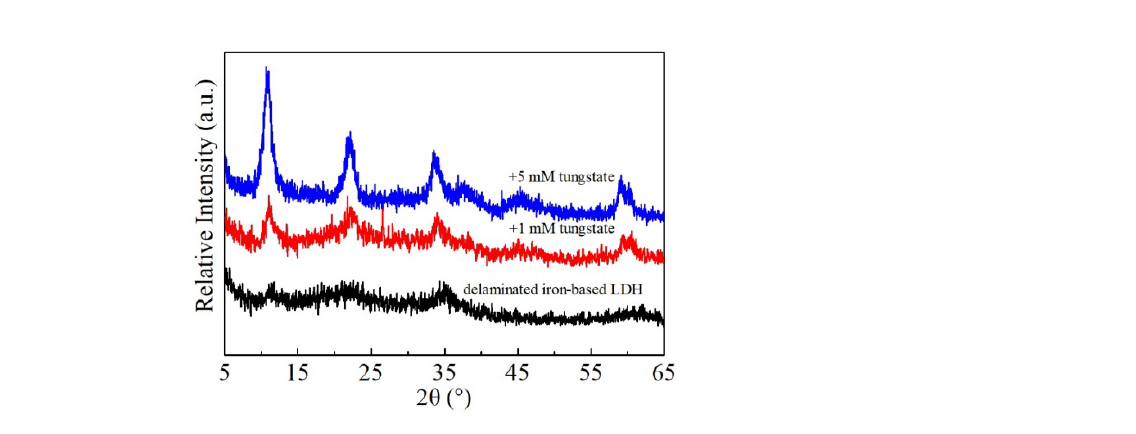
Figure 10. XRD patterns of delaminated iron-based LDH after reacting with tungstate-bearing solutions.